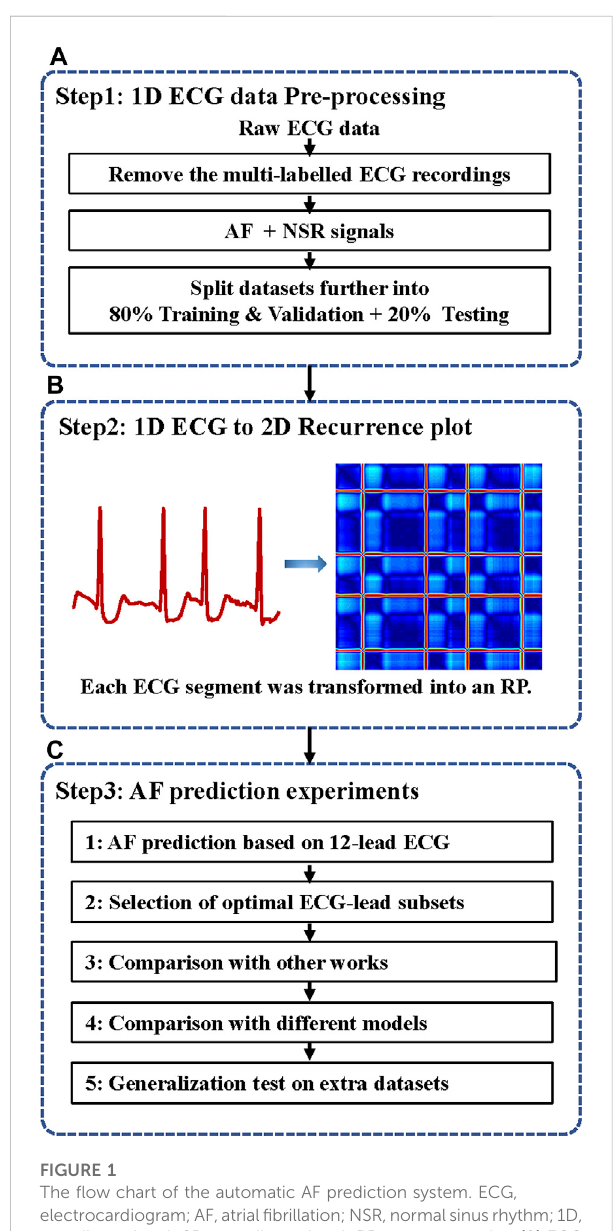
FIGURE 1 The fl ow chart of the automatic AF prediction system. ECG, electrocardiogram;AF,atrial fi brillation;NSR,normalsinusrhythm;1D, one dimensional; 2D, two dimensional; RP, recurrence plot. (A) ECG data pre-processing. (B) ECG data were transformed into RP images. (C) AF prediction experiments based on 12-lead ECG and selected the minimal ECG-lead subsets. The validation superiority of theproposed method and testingthe generalization ondifferentextra